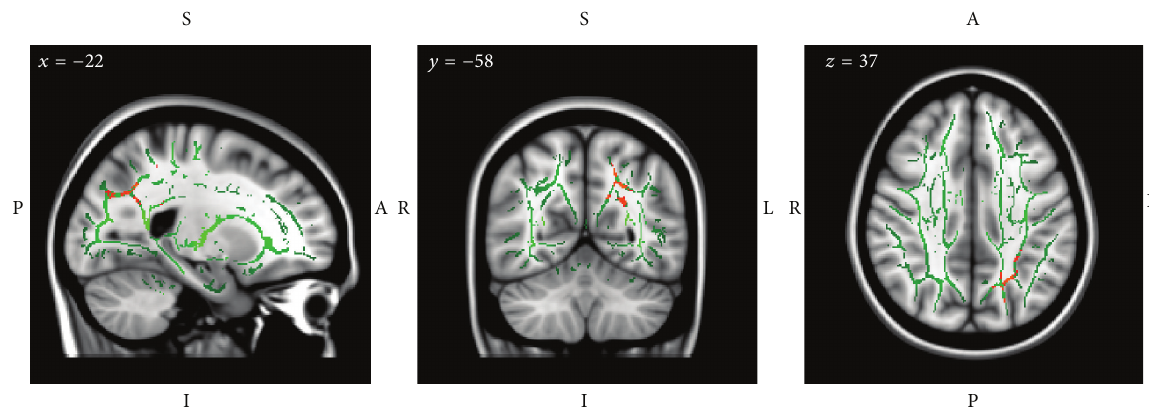
Figure 5: Tract-based spatial statistical analysis in Group C detected significant increases (Post and Pre) in fractional anisotropy (FA) in the left posterior white matter. Gray: MNI152 T1 template image, green: intergroup average white matter skeleton, and red-yellow: voxels that show threshold-free cluster enhancement-corrected significant ( 𝑃 < 0.05 ) increases in FA in Group C. Note that the images are displayed according to radiological convention, with the right hemisphere on the left.